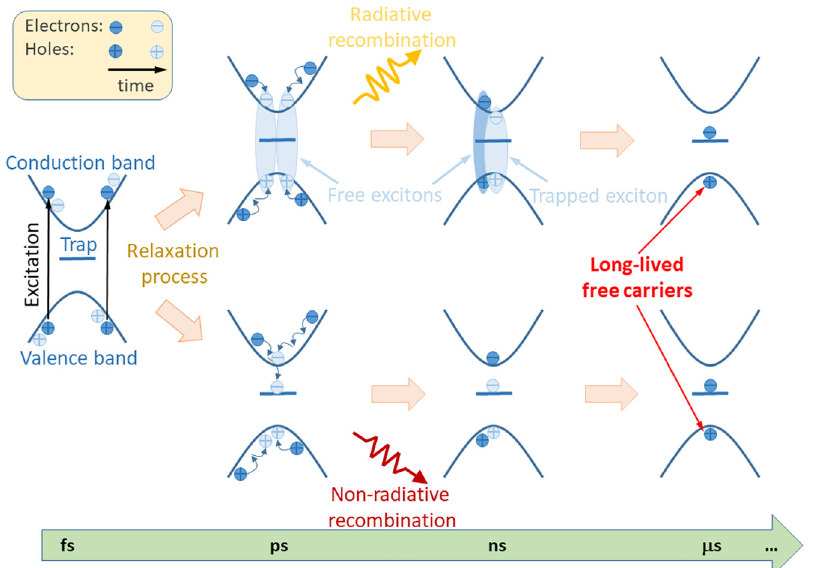
Figure 3: Sketch of carrier dynamics in monolayerTMDs.Thetrapisasurfacestate or a state that is associated with a point defect. In general, it can be either an electron trap or a hole trap (the case with an electron trap is shown). Long-lived holes remain in TMD samples due to the rapid capture of electrons (excitons) by electron